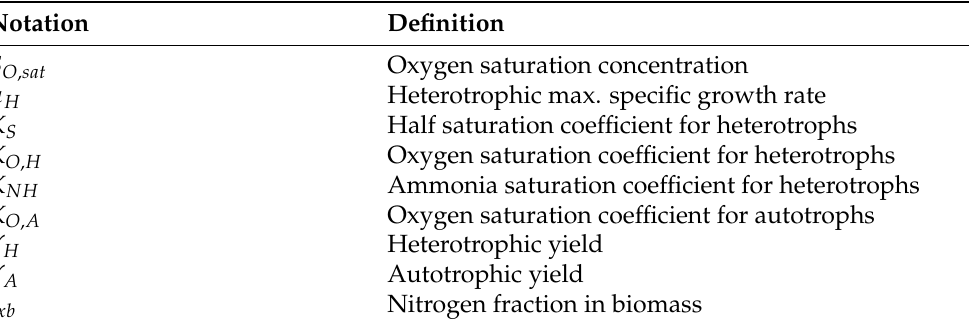
Table 3. Kinetic parameters and stoichiometric coefficient characteristics.